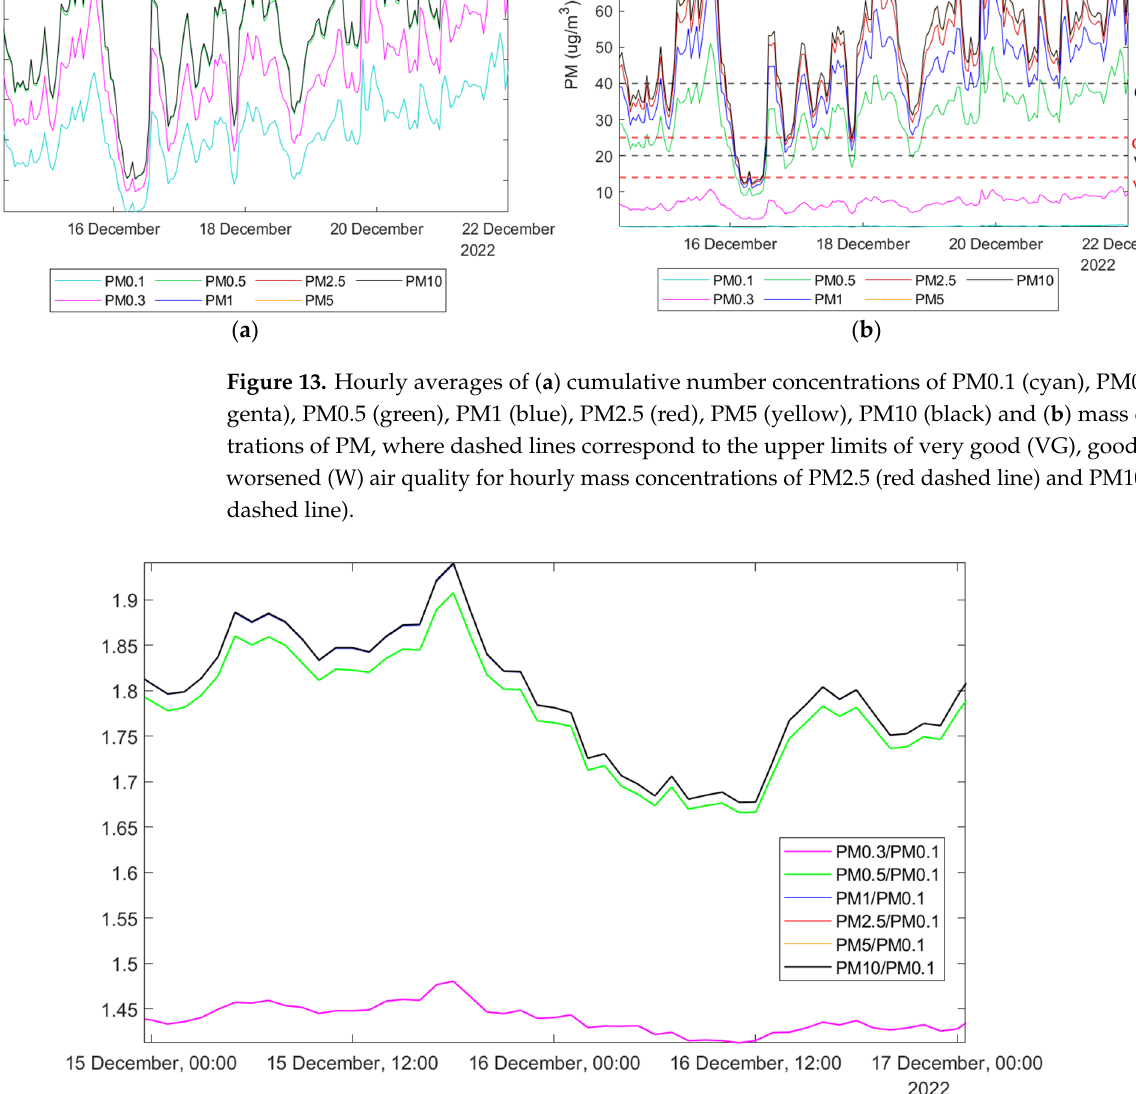
Figure 14. The ratios of PM number concentration averages—PM0.3 to PM10/PM0.1. PM1/PM0.1 (blue), PM2.5/PM0.1 (red) and PM5/PM10 (yellow) ratios are so close to PM10/PM0.1 (black) that the lines appear identical.